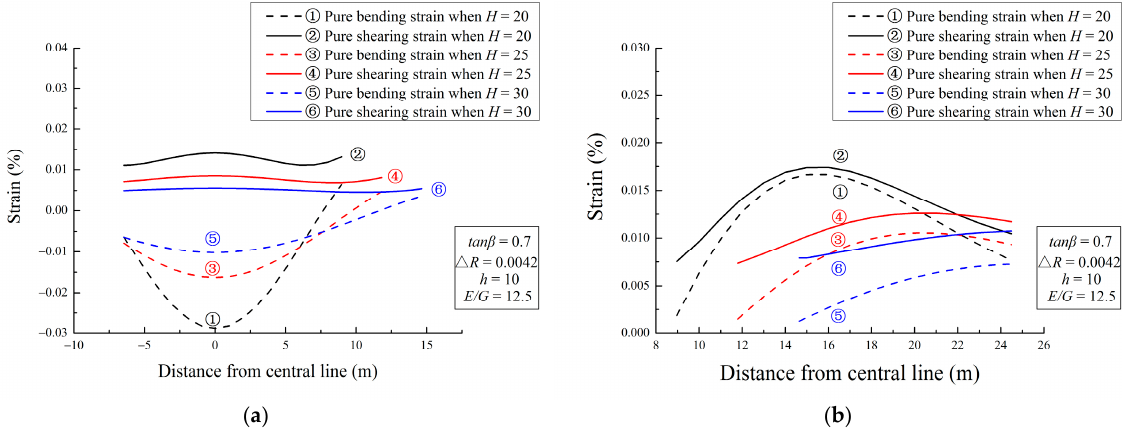
Figure 14 . E ff ect of the excavation depth on the tensile strain in ( a ) the sagging zones and ( b ) the hogging zones . hogging